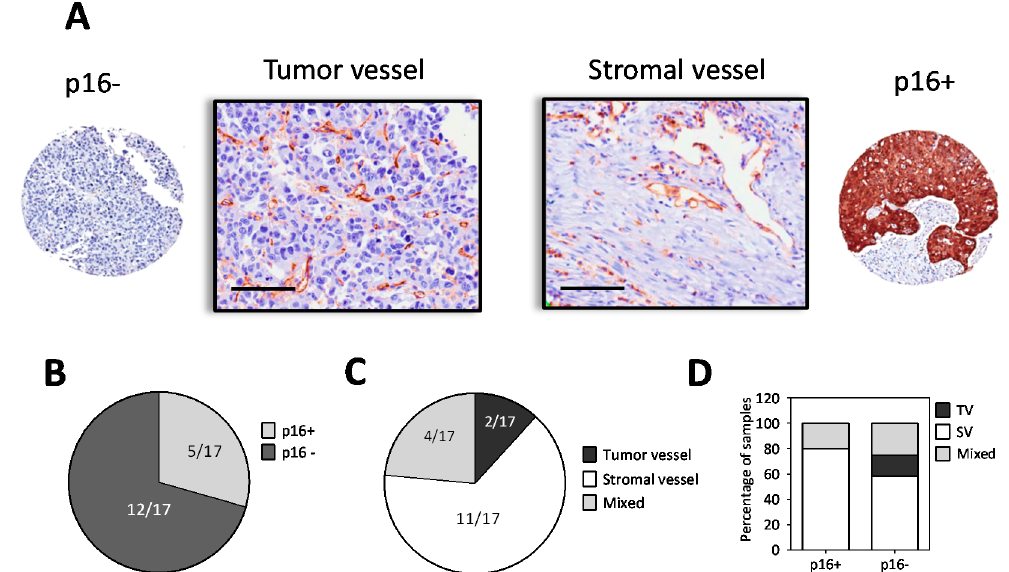
Figure 3. Heterogeneity in vascular phenotype of p16+ and p16 − human HNSCC. ( A ) Figure3. Heterogeneityinvascularphenotypeofp16 + andp16 − humanHNSCC.( A )Photomicrographs Photomicrographs of p16 and CD31-immunostained tissue microarray (TMA) cores of human of p16 and CD31-immunostained tissue microarray (TMA) cores of human HNSCC. Images are shown HNSCC . Images are shown at 20× magnification, scale bar represents 100 μ m. A p16 negative (p16 − ) at 20 × magnification, scale bar represents 100 µ m. A p16 negative (p16 − ) sample with a tumor vessel sample with a tumor vessel (TV) phenotype and a p16 positive (p16+) sample with a stromal vessel (TV) phenotype and a p16 positive (p16 + ) sample with a stromal vessel (SV) phenotype is shown. (SV) phenotype is shown. Vessels were identified as CD31+ structures with a visible lumen. ( B ) Vessels were identified as CD31 + structures with a visible lumen. ( B ) Incidence of p16 + and p16 − Incidence of p16+ and p16 − samples in the TMA. ( C ) Incidence of the three different vessel phenotypes samples in the TMA. ( C ) Incidence of the three di ff erent vessel phenotypes in the TMA. ( D ) Distribution of the vessel phenotypes in the TMA stratified by p16